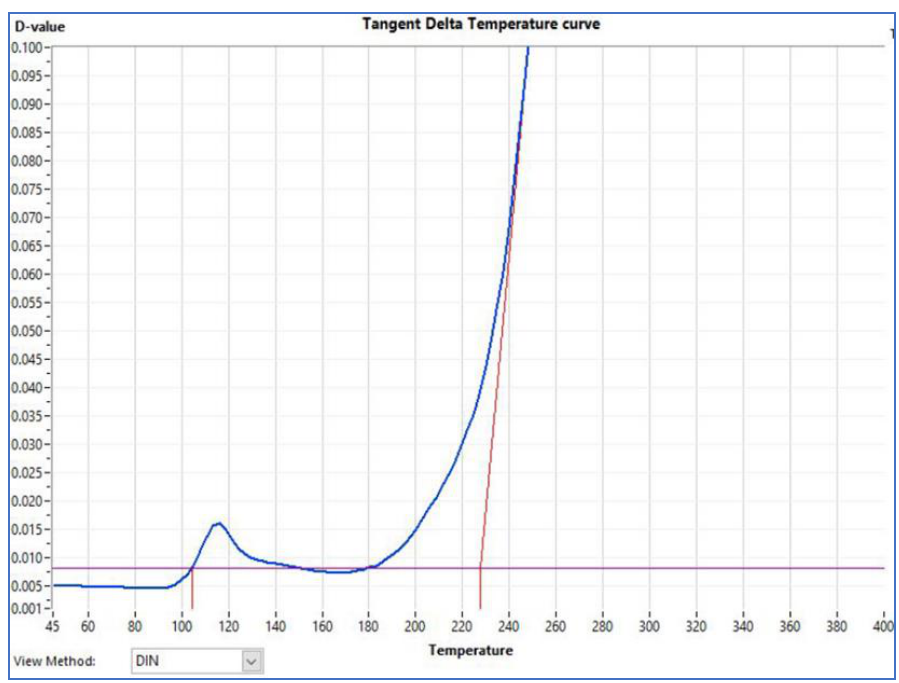
Figure 7. Tangent delta behavior for the wires PEI + thermoplastic polymer.